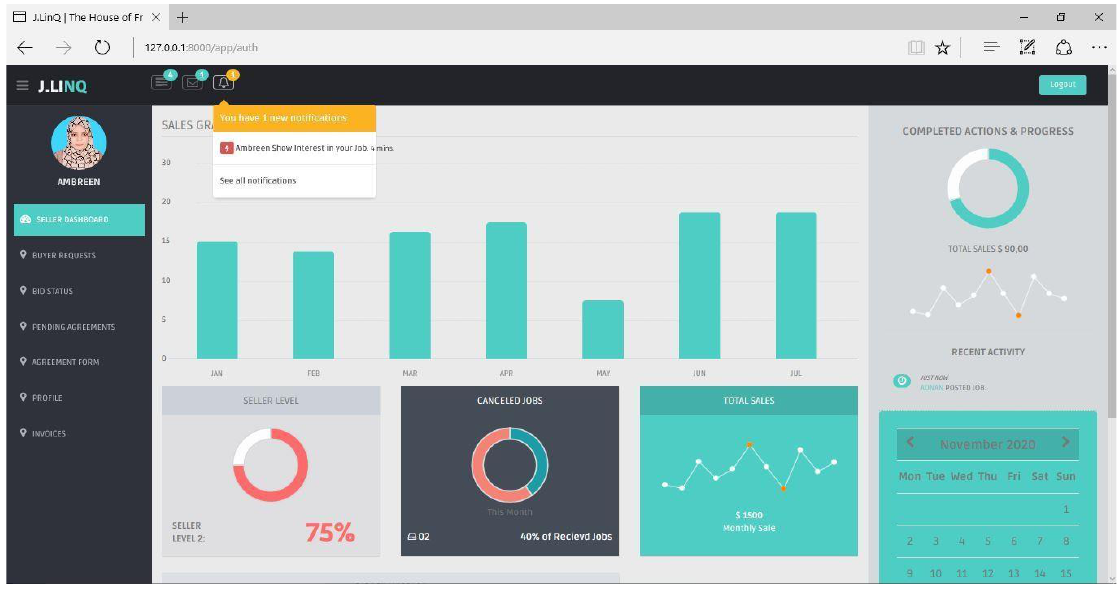
Figure 11. Seller dashboard and profile.